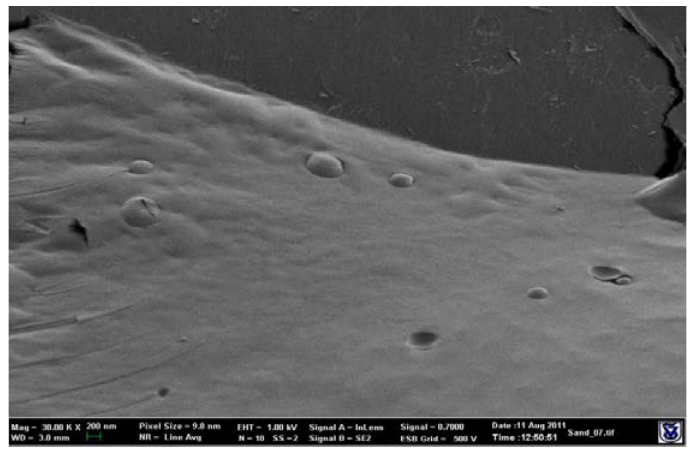
Figure 2. Cryo-scanning electron (cryo-SE) micrograph of a buspirone NDS (Zeiss Ultra Plus HR-SEM) showing multiple nanovesicles.